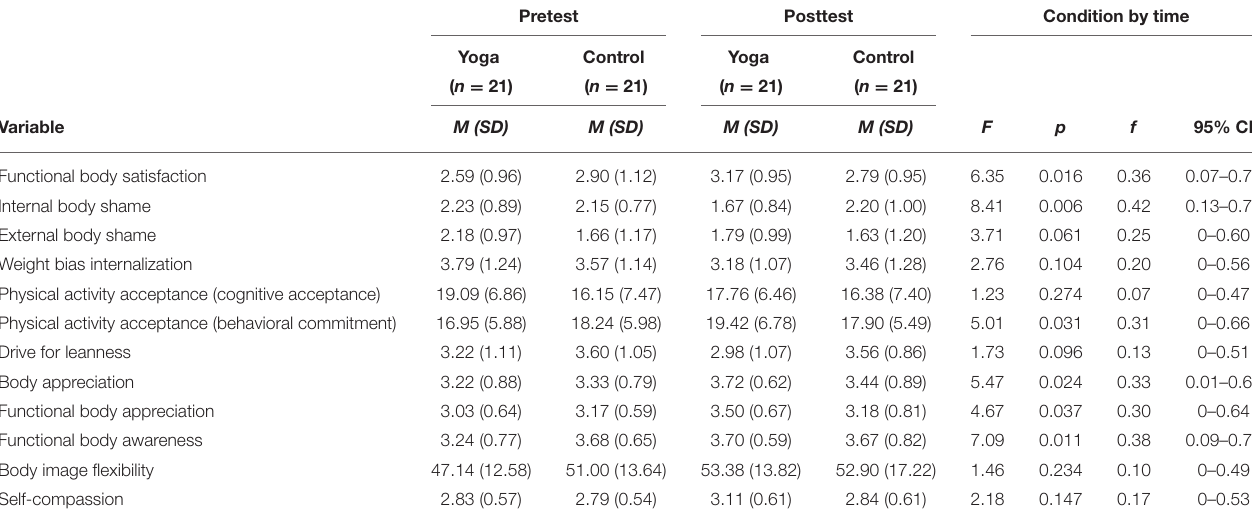
TABLE 3 | Means and summary statistics for mixed-model analysis for outcome variables for yoga condition by assessment time from pre- to posttest. Pretest Posttest Condition by